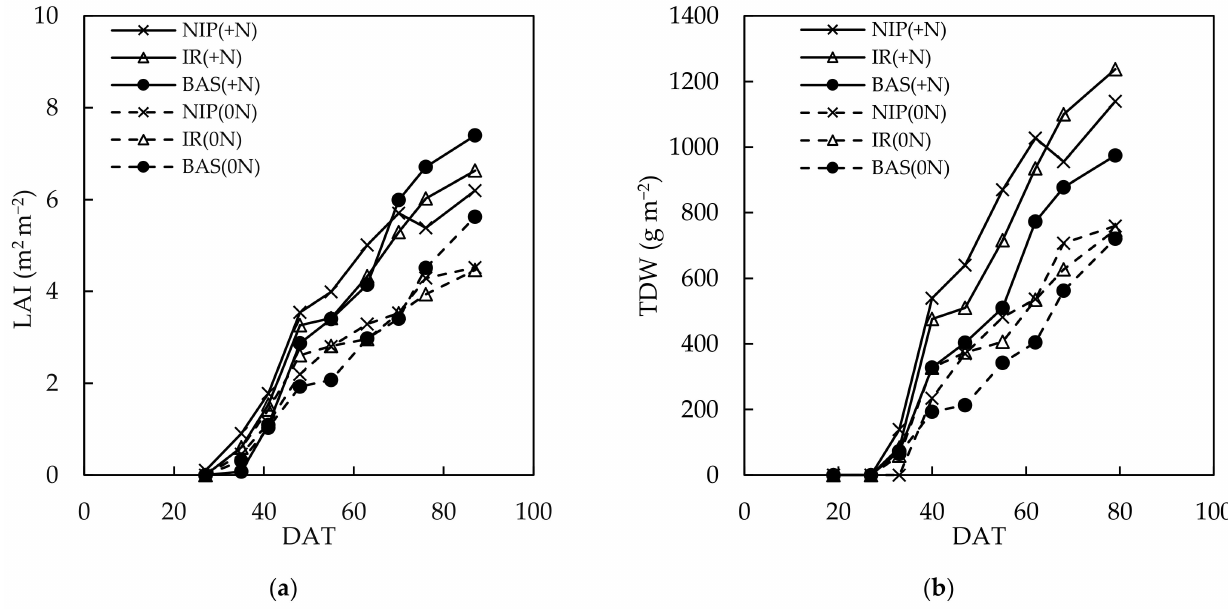
Figure 12. Observed temporal changes of estimated ( a ) LAI and ( b ) TDW in 2019 (Rep. 2) at various days after transplanting